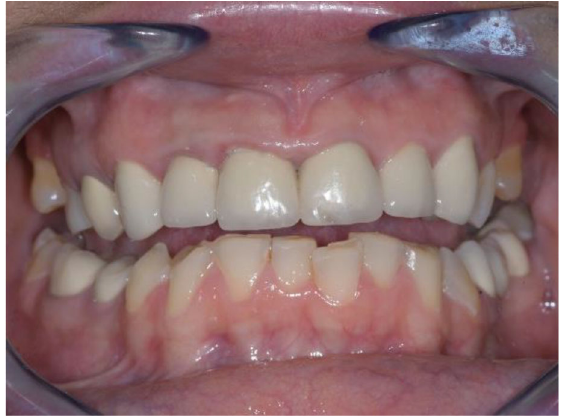
Figure 1. Initial clinical situation – Abraded lower teeth and incorrect occlusal plane.